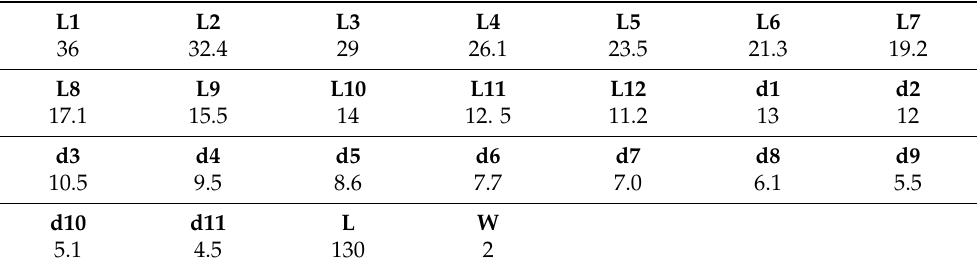
Figure 6. Log-period antenna with parasitic patch. Table 2. Original size of log-periodic antenna